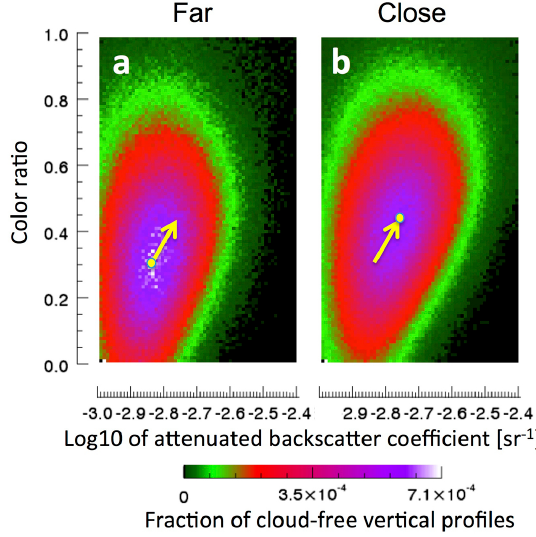
Fig. 1. Joint probability density functions (pdf) of color ratio (ratio of 1064nm and 532nm attenuated backscatters) and 532nm atten- uated backscatter coefficient vertically integrated below 3km alti- tude. (a) cloud-free columns farther than 5km from the nearest low cloud along the CALIOP track, (b) cloud-free columns closer than 5km to the nearest low cloud. The origins of the identical yellow arrows indicate the mode of the left pdf, while the ends of the ar- rows indicate the mode of the right one. For the nighttime dataset analyzed in this figure, low clouds are detected using the Version 3 CALIOP vertical feature mask, and are defined as clouds for which CALIOP indicates a cloud top altitude of less than